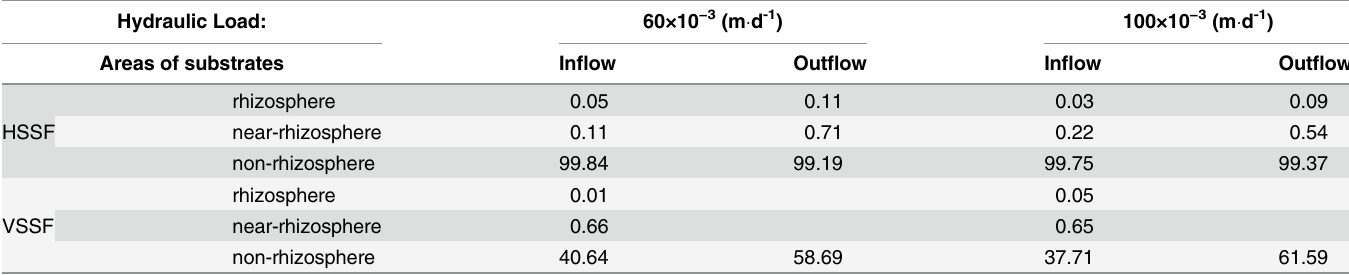
Table 1. Percentages of different parts of substrates(dry weight) in four CWs (%). Hydraulic